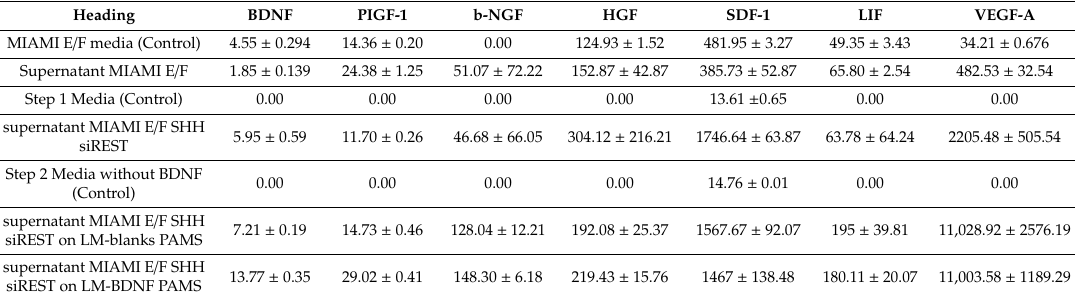
Figure A1. Neuroprotective effect of cells injection on the GABAergic degeneration. Immunohistochemistry against striatal GAD67-positive neurons and DARPP32-positive neurons at Day 25 after injection of media, cells alone, cells on blank PAMs and cells on BDNF PAMs in the ex vivo model of HD. Scale bar is 100µm ( N = 2). Table A1. Raw data of the secrotome analysis. Media collected from MIAMI E/F cells, MIAMI-SHH-SiREST cells or 72 h after adherence between cells and PAMs were analyzed by the Luminex apparatus for the quantification of growth factors and cytokines ( N = 2, n = 2).